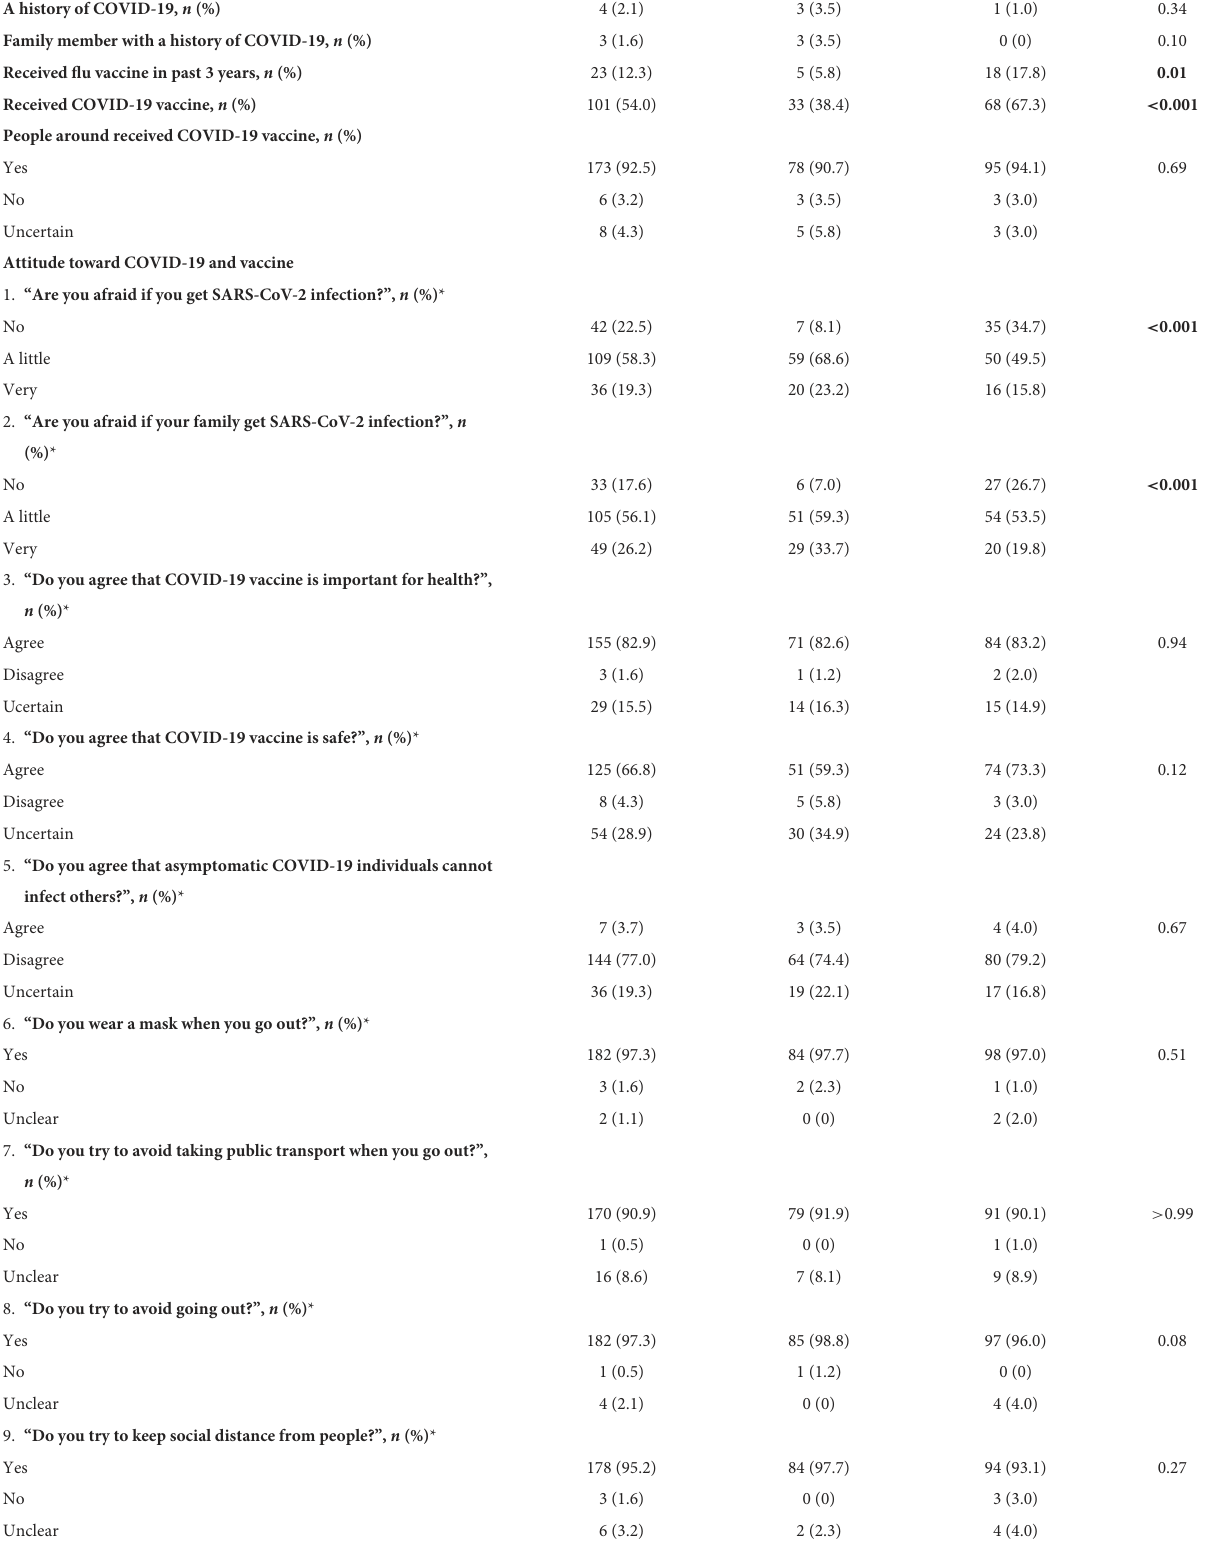
TABLE 2 History and attitude of COVID-19 and COVID-19